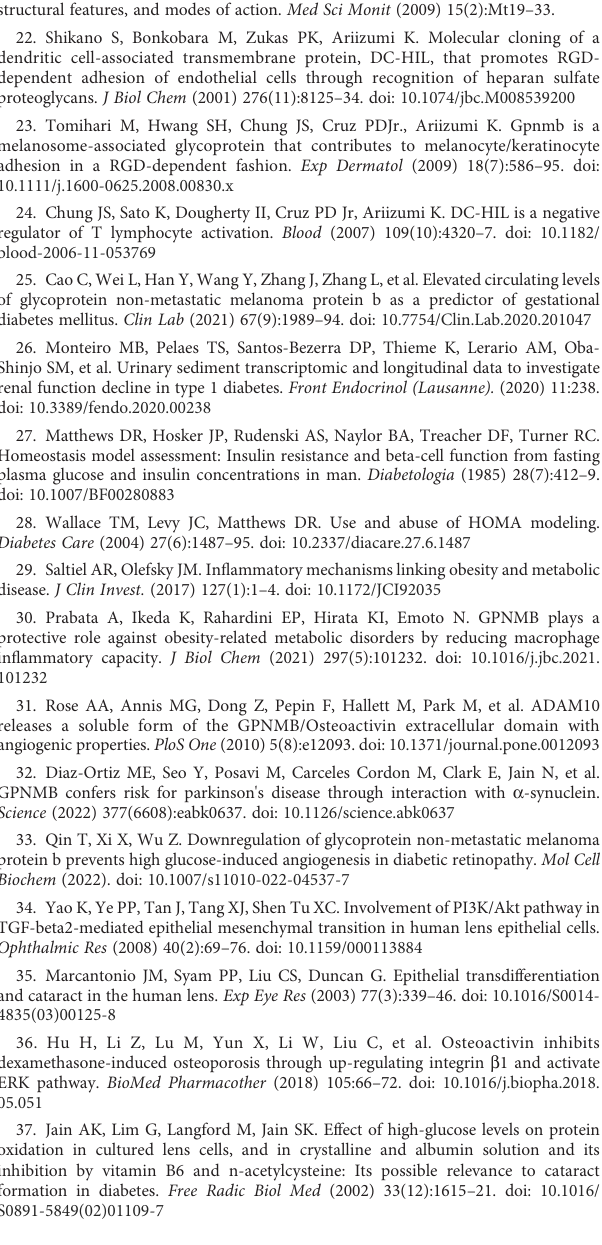
SUPPLEMENTARY FIGURE 1 The linear correlation of log GPNMB with different variables through